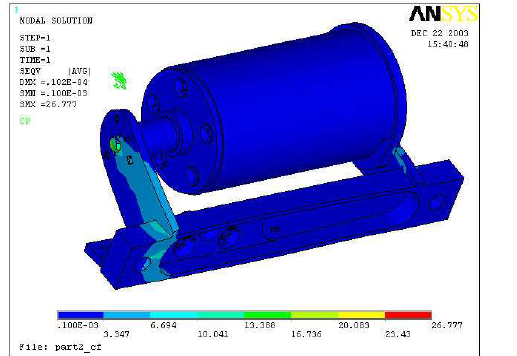
Fig. 11. Strength Analysis of Subassembly ‘A’.